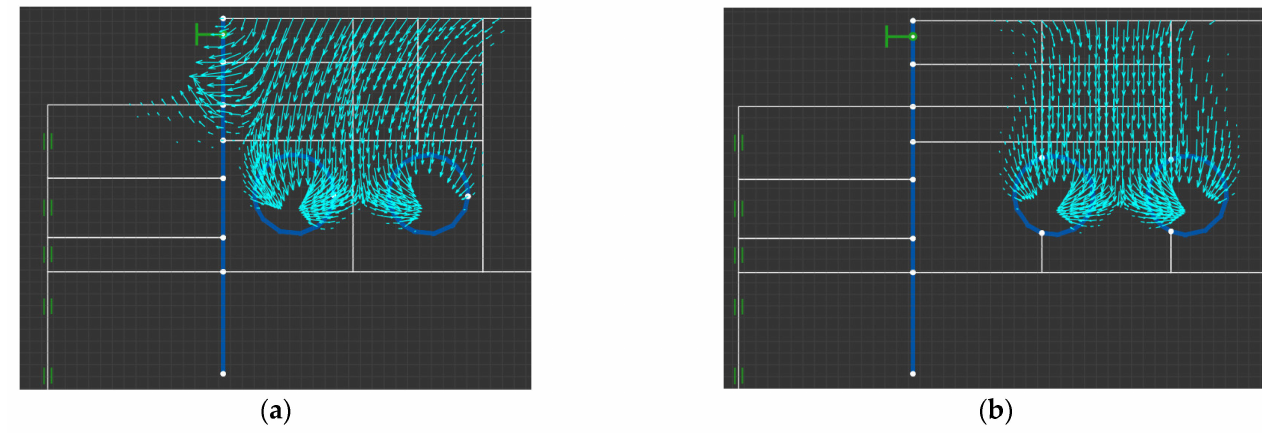
Figure 14. Incremental displacement vector under different horizontal distance L in stage (2): ( a ) L = 0.33 H and ( b ) L = 0.5